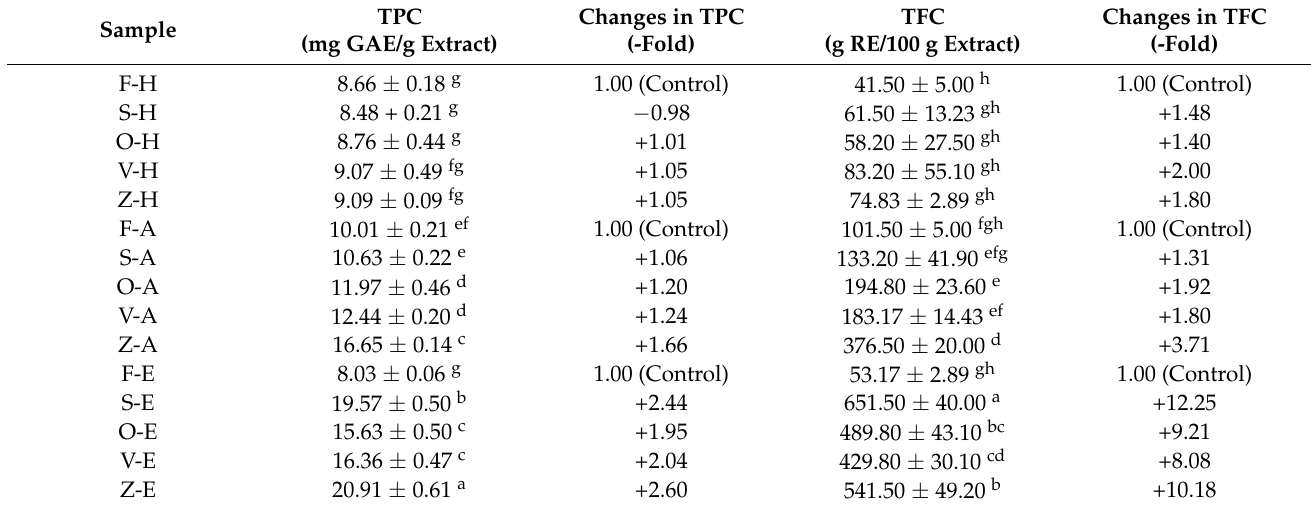
Table 1. Total phenolic content (TPC) and total flavonoid content (TFC) of Bentong ginger extracted using hot water, aqueous ethanol, and ethanol solvents via sun-, oven-, vacuum- and freeze-drying methods. Changes were calculated based on the respective fresh ginger